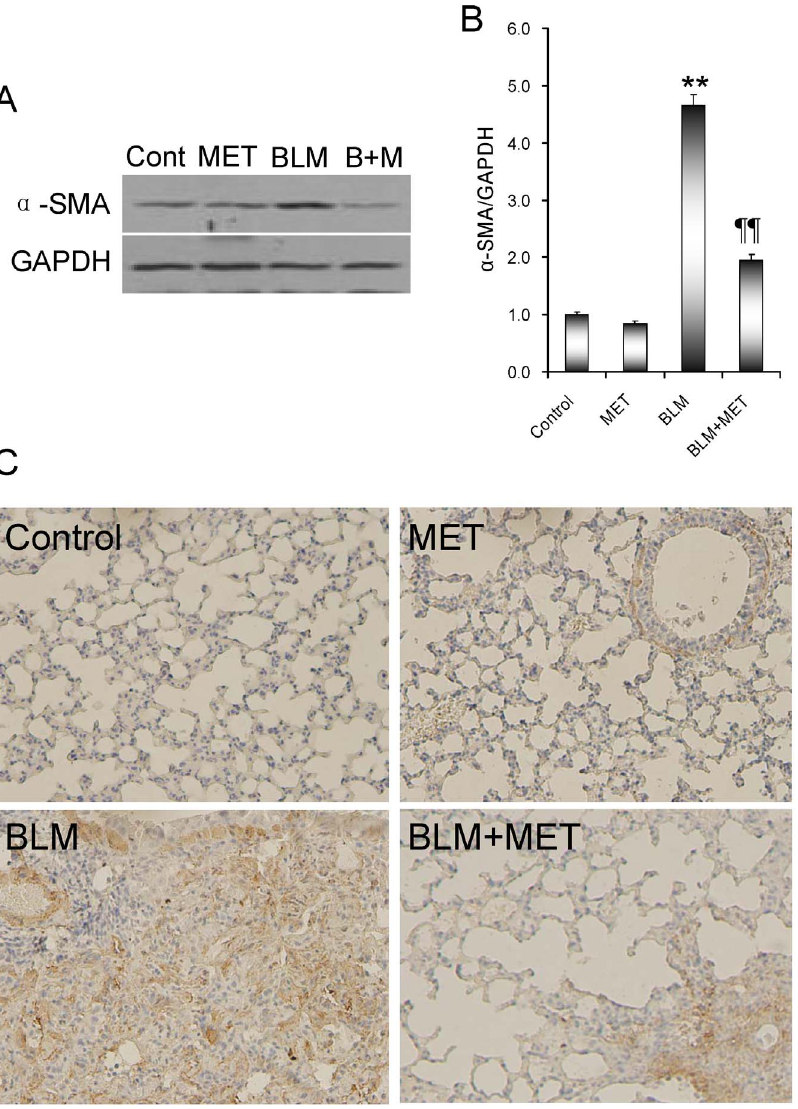
Figure 3. The effects of melatonin on BLM-induced pulmonary a -SMA expression. All mice except controls were intratracheally injected with BLM (5.0 mg/kg). In BLM + melatonin group, mice were i.p. injected with melatonin (5 mg/kg) daily. Lungs were collected at 21 days after BLM. (A and B) The expression of pulmonary a -SMA was detected using immunoblots. All experiments were replicated for four times. The data were expressed as means 6 SEM (n=4). ** P , 0.01 as compared with control group. `` P , 0.01 as compared with BLM group. (C) Pulmonary a -SMA was detected by immunohistochemistry. All experiments were replicated for four times. Original magnification: 200 6 .